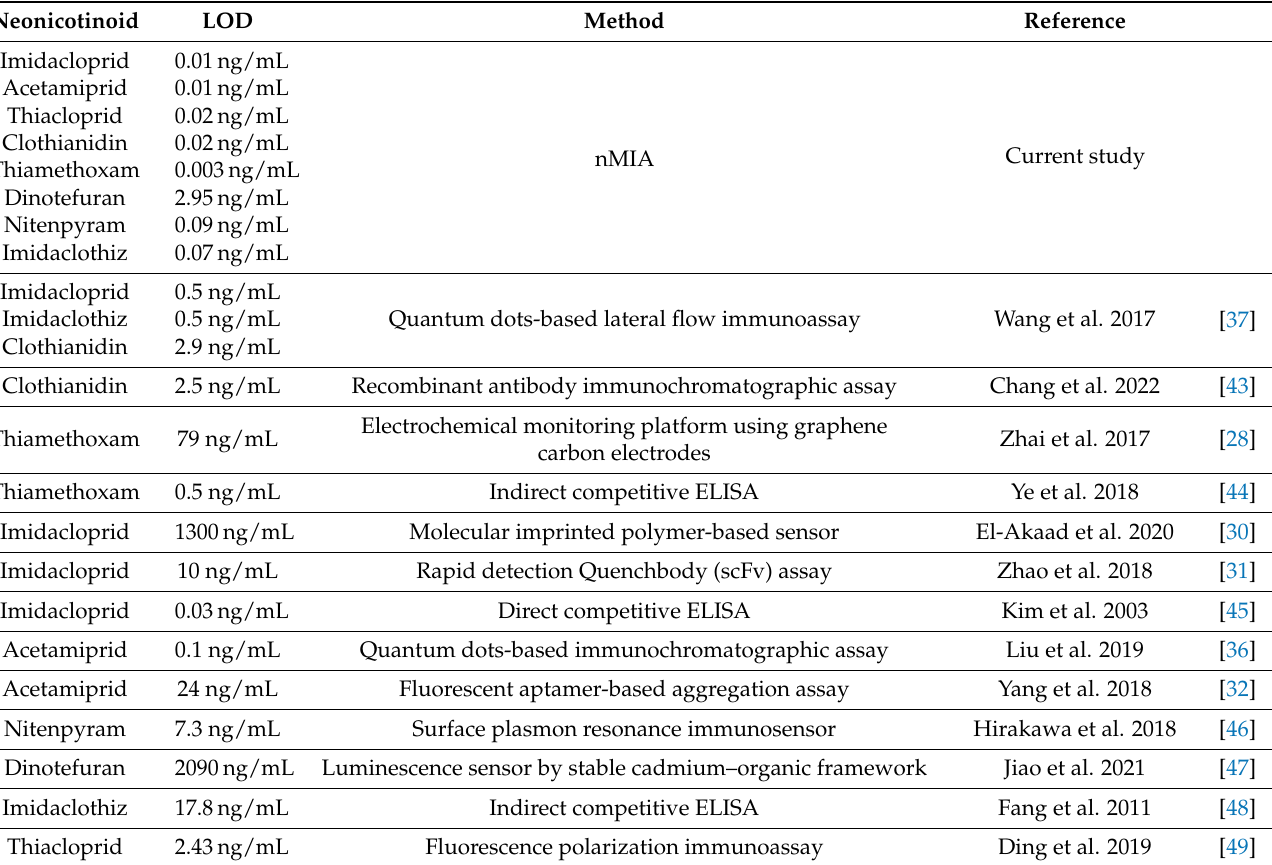
Table 2. Sensitivities (LODs) of the developed nMIAs and other neonicotinoid detection technologies from the